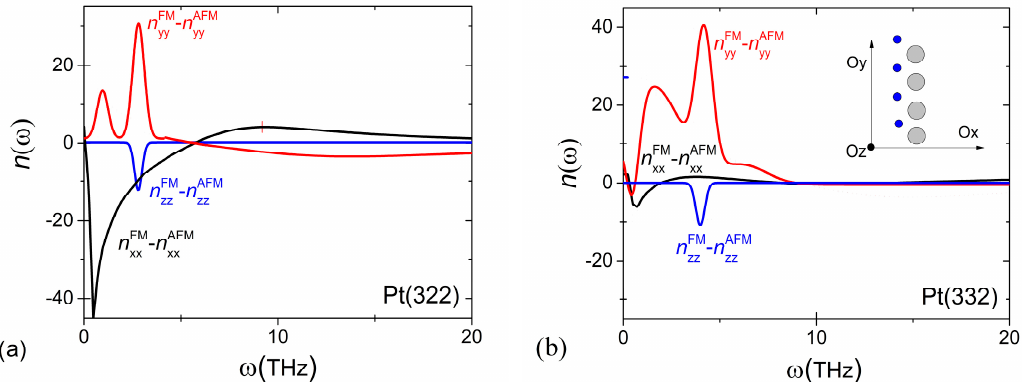
Figure 2. Refractive indexes differences of CoO nanowire on Pt(322) ( a ) and Pt(332) ( b ) surfaces in low oxidized state for FM and AFM magnetic configurations. low oxidized state for FM and AFM magnetic